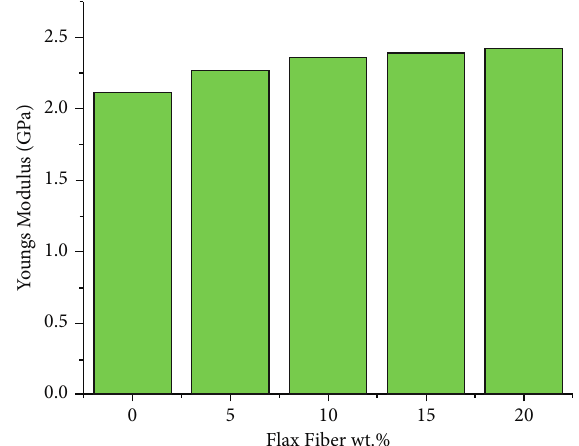
Figure 6: Effect of flax fibre content on Young’s modulus of pure and hybrid